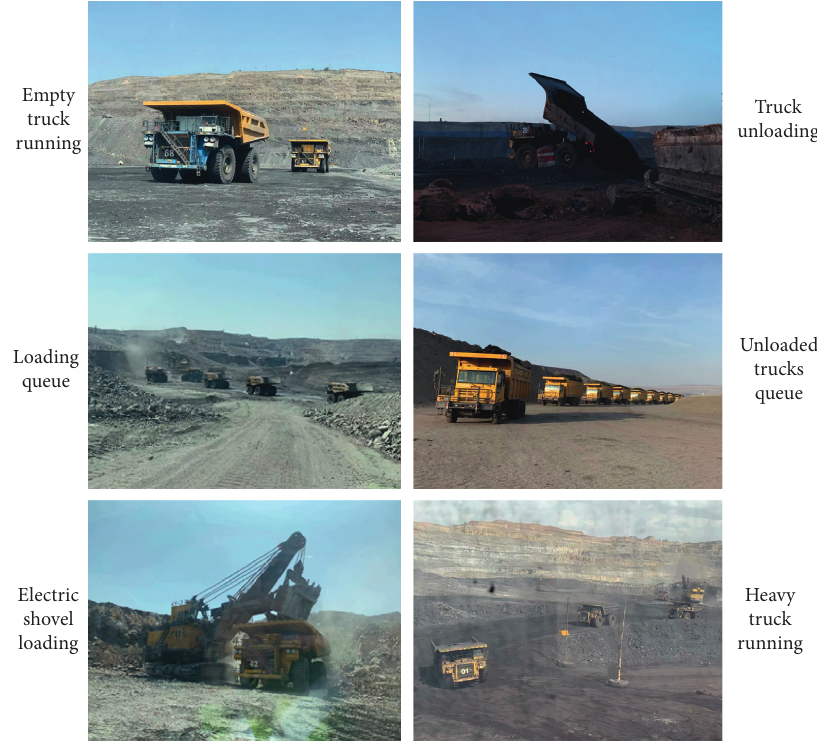
Figure 4: Truck running cycle of coal mining semicontinuous process